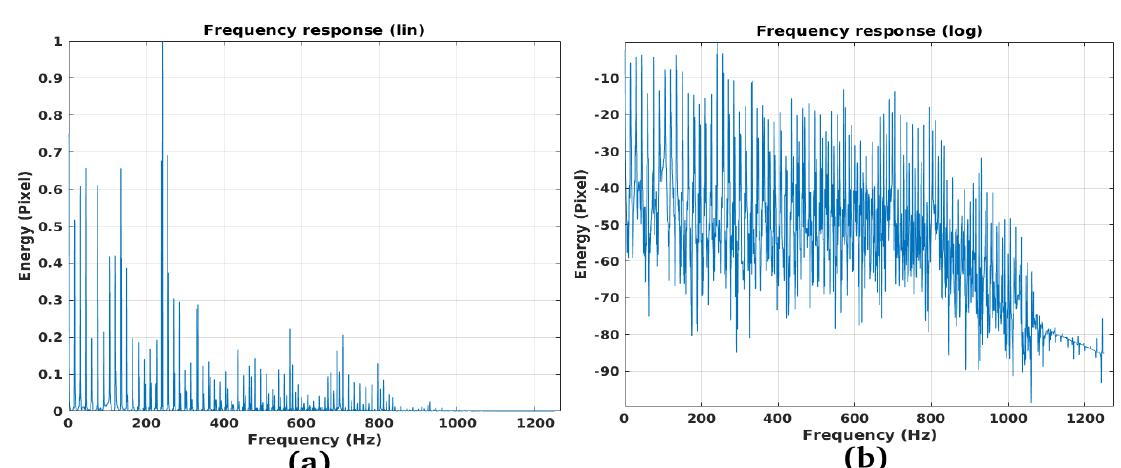
Figure 24. Vibration spectrum trends (DFT of Figure 23): ( a ) Linear trend, ( b ) Logarithmic